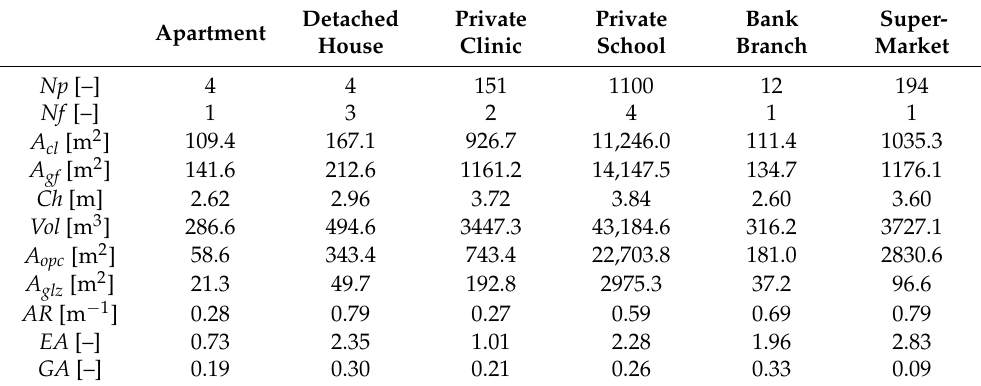
Table 2. Summary of the characteristics of the 6 buildings considered: Np —maximum number of occupants; Nf —number of floors; A cl —acclimatized floor area; A gf —gross floor area; Ch —ceiling height; Vol —acclimatized volume; A opc —opaque area of external envelope; A glz —glazed area